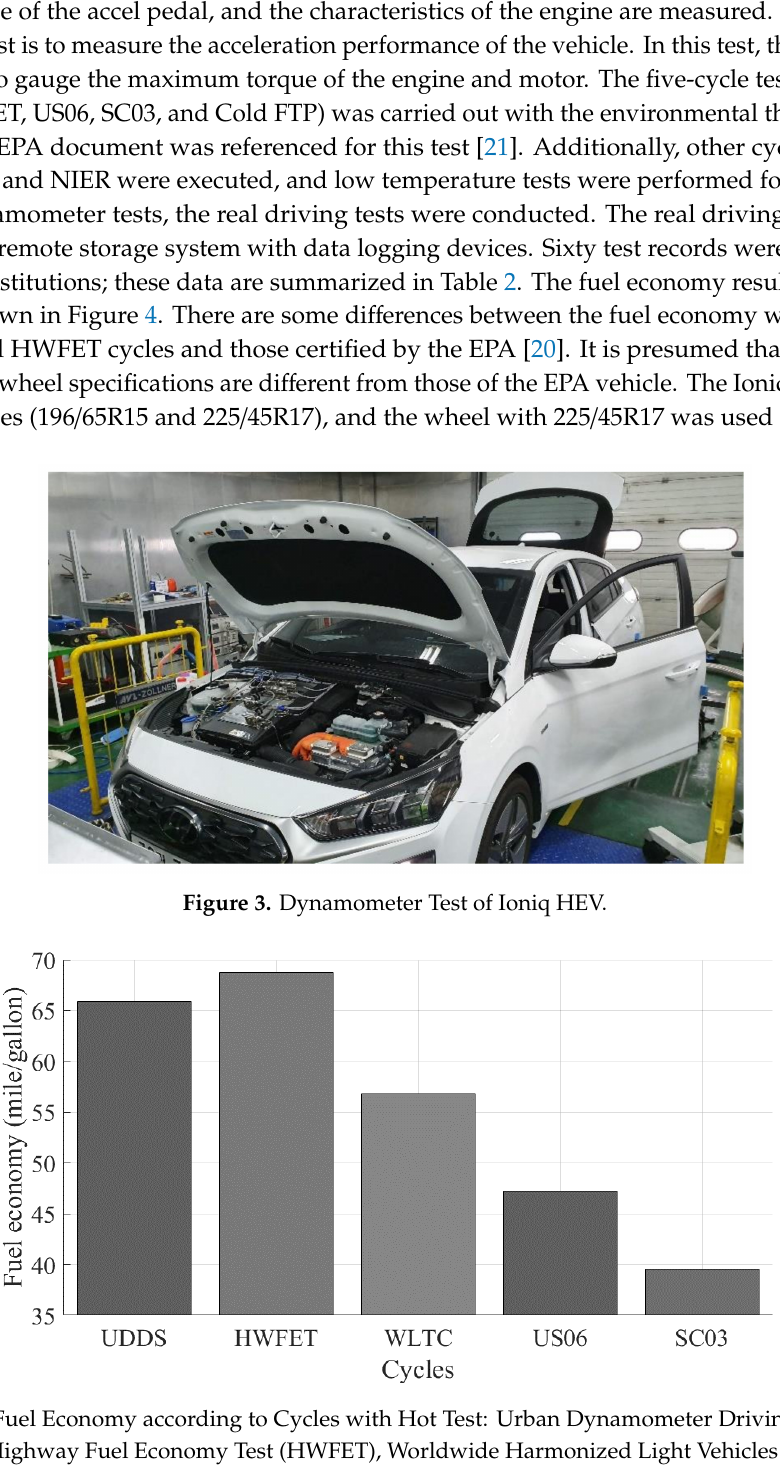
Table 2. Dynamo and Real Driving Test Data.